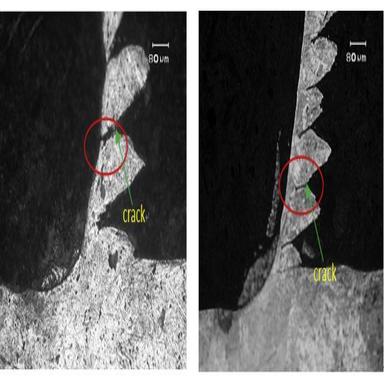
Chip fracture at different cutting speeds.